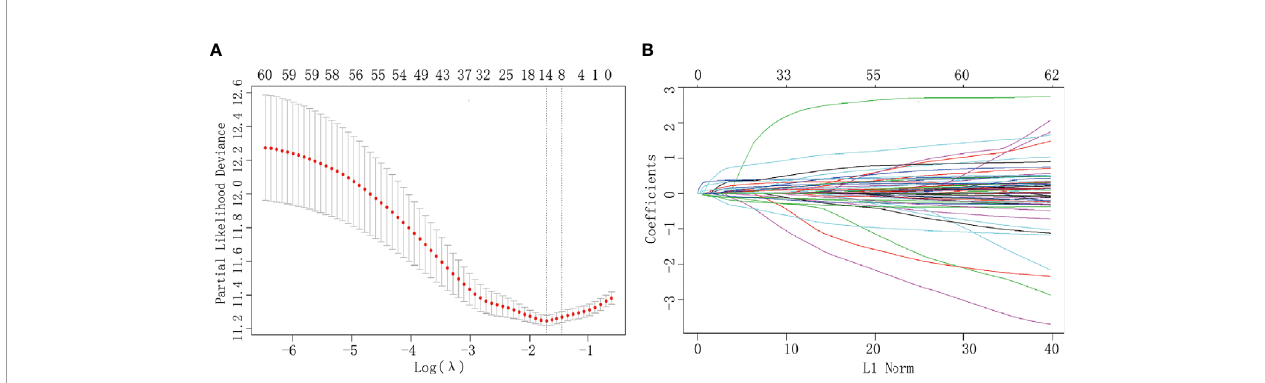
FIGURE 1 | Clinicopathological parameter identi fi cation and feature selection using the LASSO regression model. (A) Tenfold cross-validation was applied to select the most suitable feature using the LASSO COX regression model. (B) Coef fi cient curves for the 62